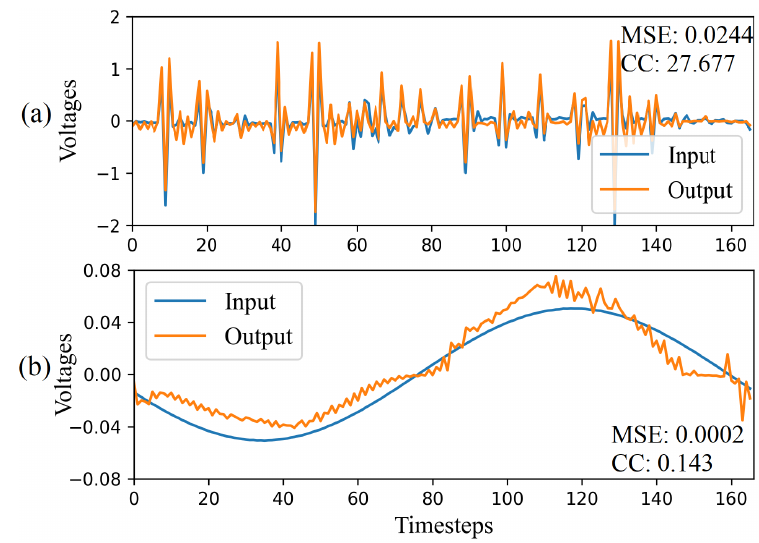
Figure 5. Input and output of the CAE for ( a ) HIF and ( b ) Non-HIF